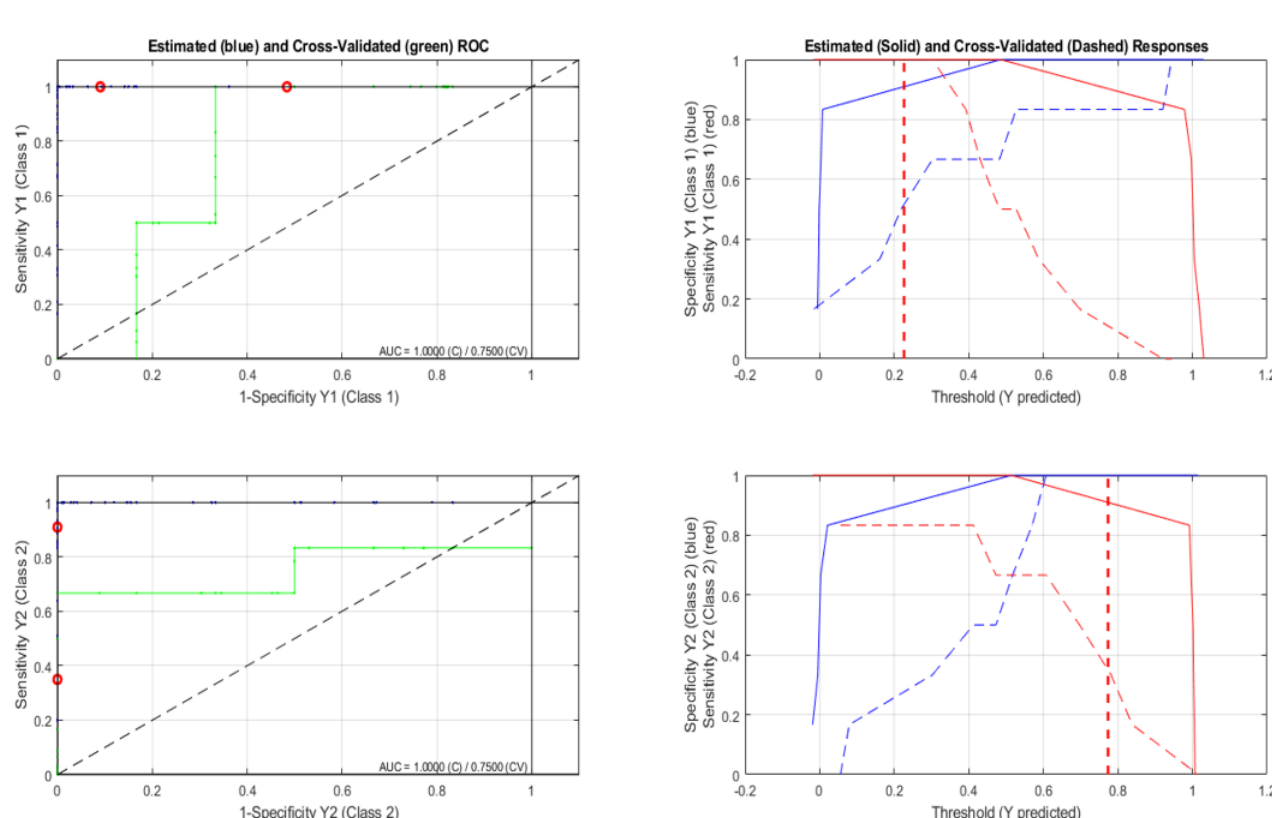
FIGURE 3 - Sensitivity and selectivity of models determined by the area under the curve of the ROC (Receiver Operator Characteristic Curve) curves